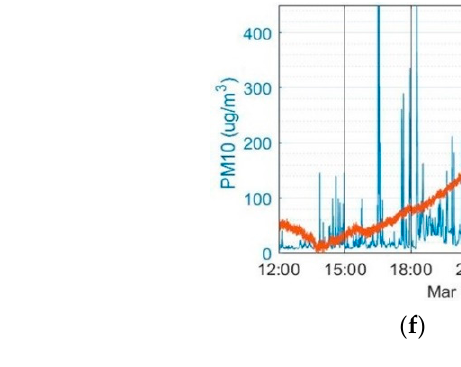
Figure 8. Changes in the measured quantities: PM10 and temperature ( a ) on 12 March 2022, ( b ) 13 March 2022; PM10 and humidity ( c ) on 12 March 2022, ( d ) on 13 March 2022, PM10 and pressure ( e ) on 12 March 2022 and ( f ) 13 March 2022; measured on the balcony.